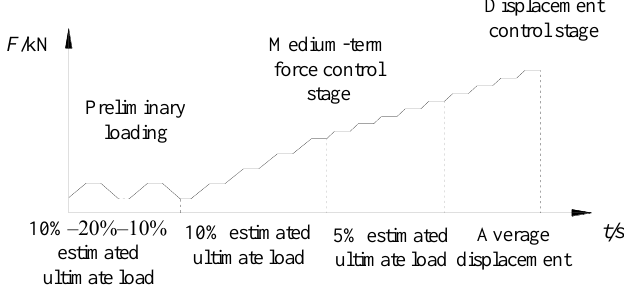
Figure 6. Diagram of the loading mechanism.